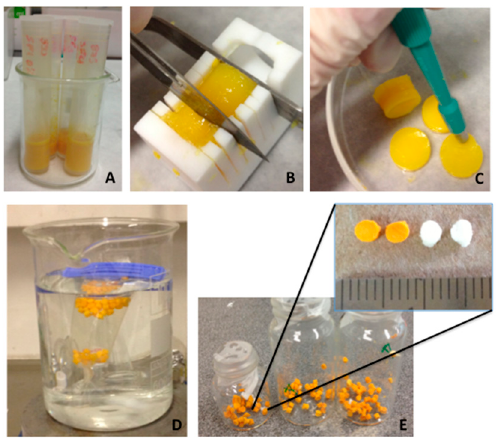
Figure 5. Procedure for scaffold construction as reported in Martin-del-Campo et al. ( A ) Solubilization and mixture of chemical components, ( B ) cutting to slices, ( C ) cutting with punch to obtain discs, ( D ) dialysis with membranes, and ( E ) final product (scaffold) [16].